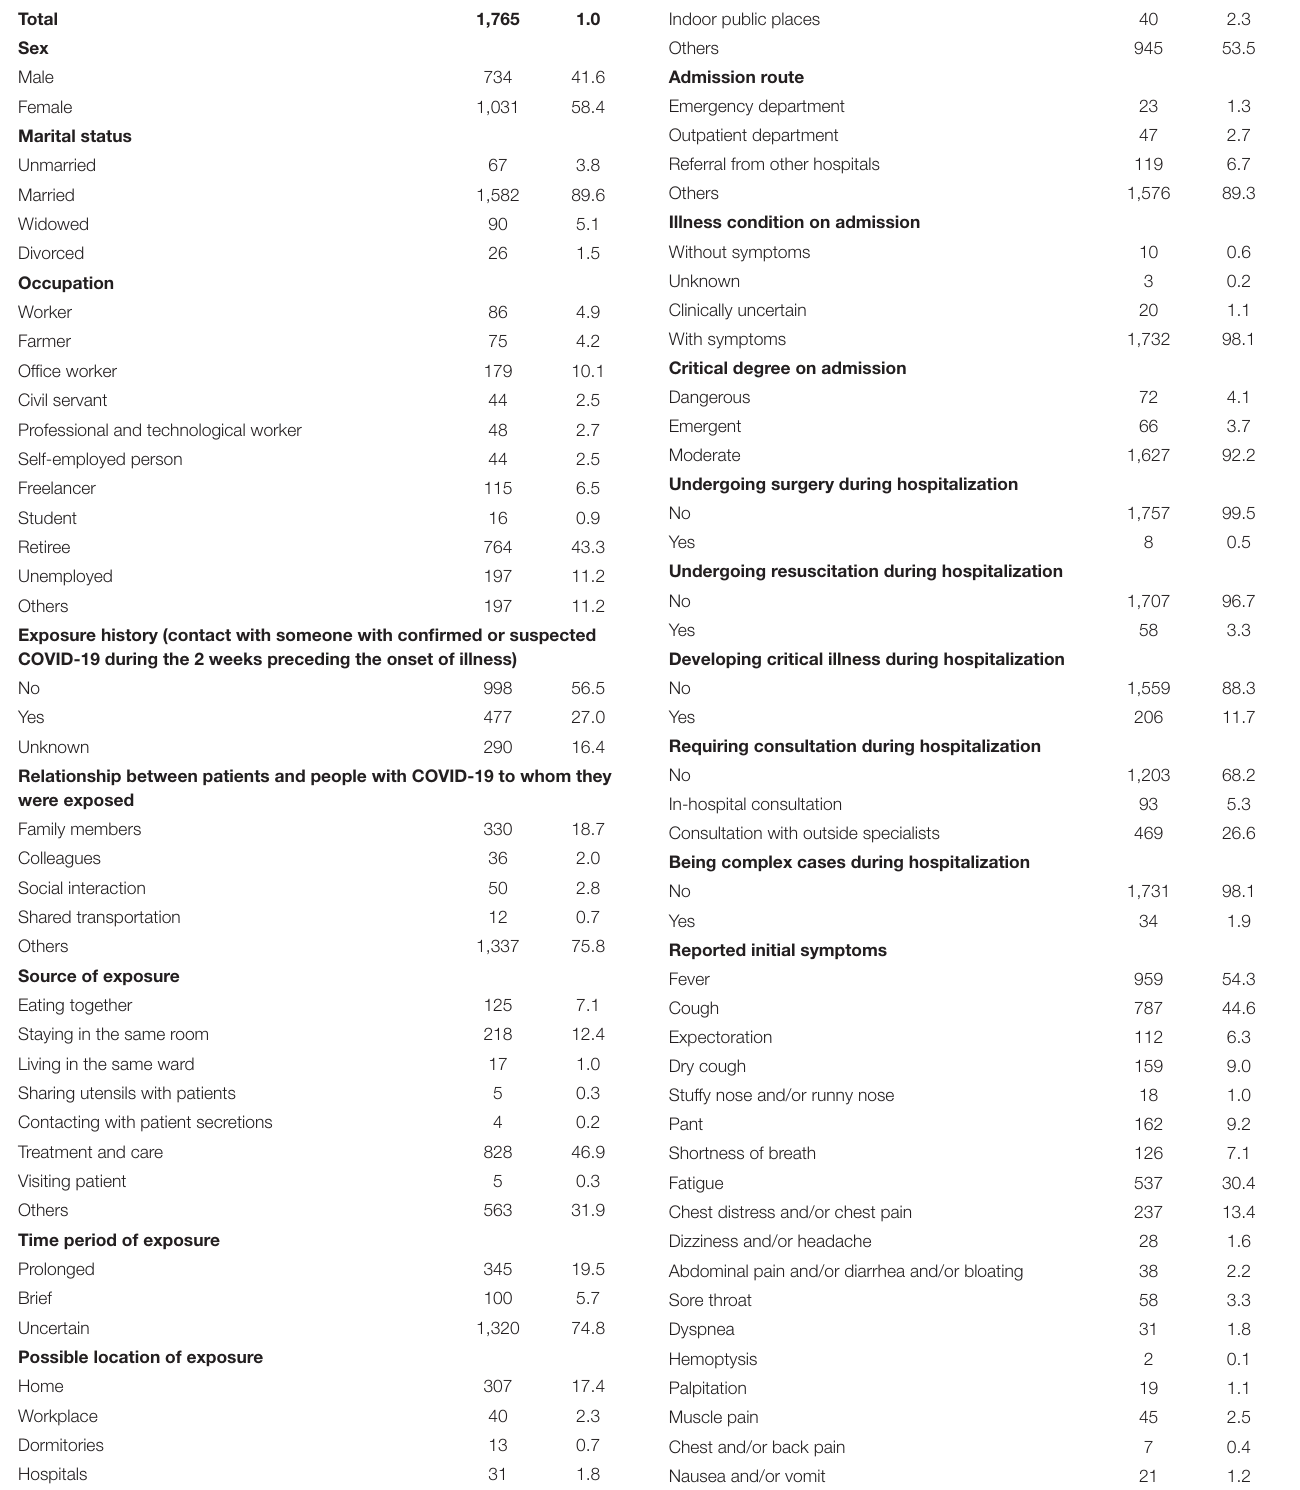
TABLE 1 | Basic characteristics of patients with COVID-19.